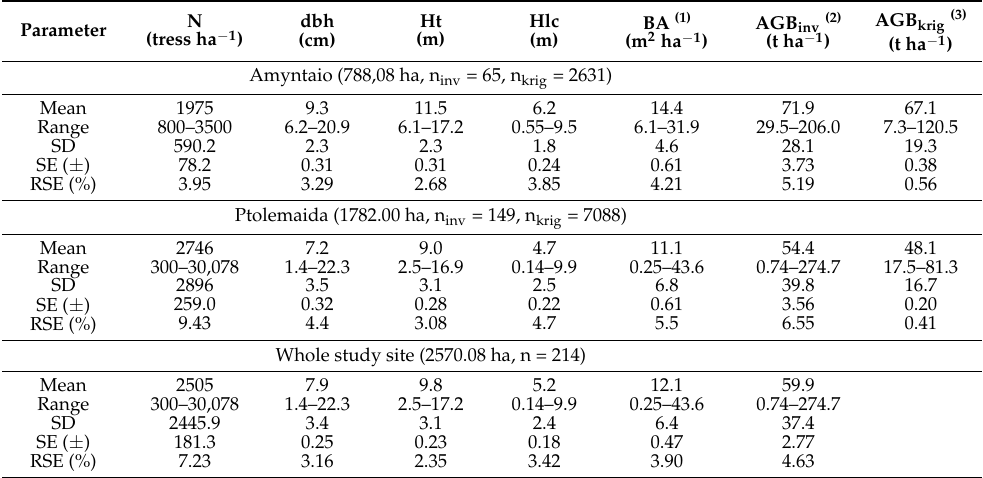
Table 1. Descriptive statistics of data measured in the forest inventory plots. Parameter N (tress ha − 1